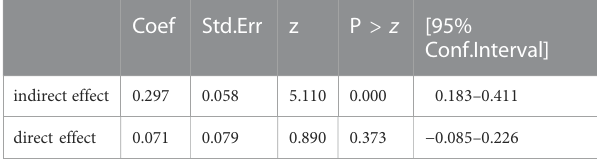
TABLE 5 Operation results of the Bootstrap of overall perceived mediation effect (Model